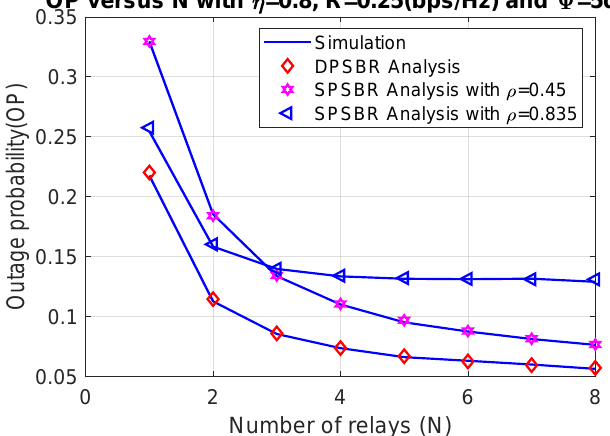
Figure 6. Outage probability versus number of relays (N).